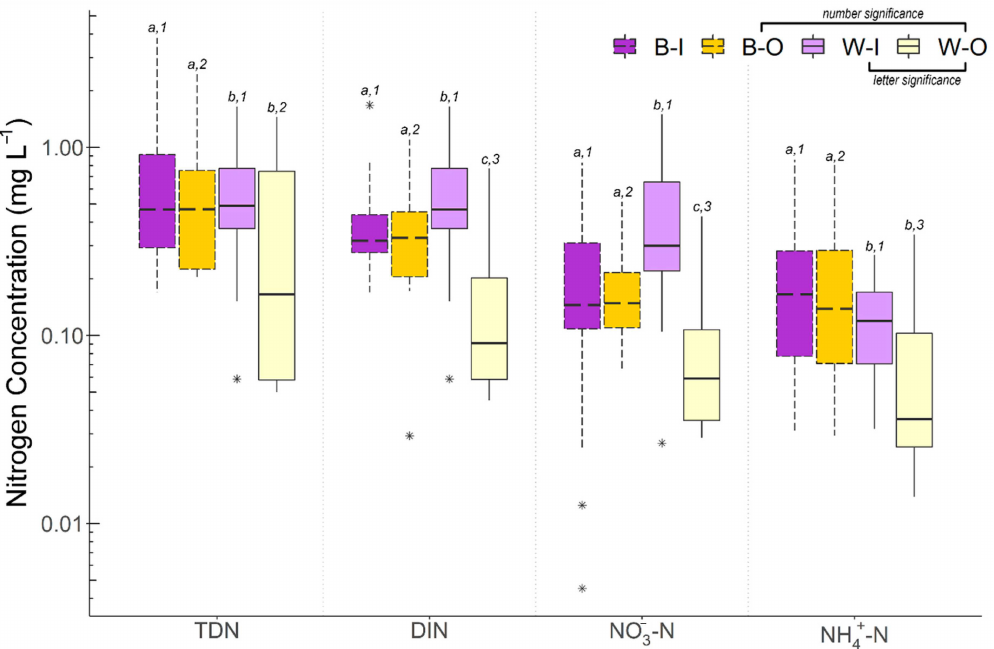
Figure 5. Boxplots of flow-weighted concentrations of total dissolved nitrogen (TDN), dissolved inorganic nitrogen (DIN), nitrate (NO 3 − N), and ammonium (NH 4 + N) at the inlet (I) and outlet (O) of the dry basin (B) and wetland (W). Letter changes indicate significant intra-control measure di ff erences in concentrations. The number of changes indicate significant inter-control measure di ff erences in concentrations. Statistical outliers indicated by